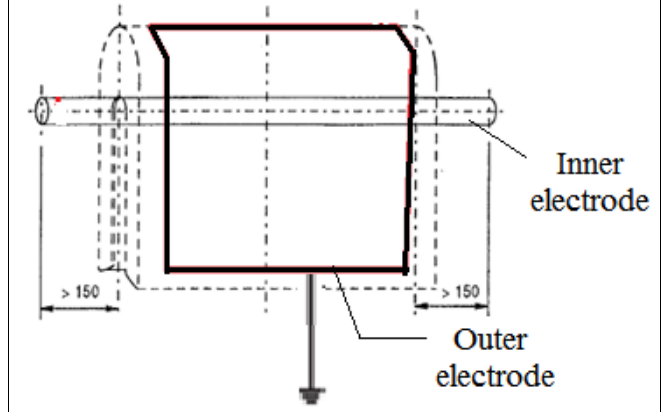
Figure 3: General test scheme for rigid cover certification.